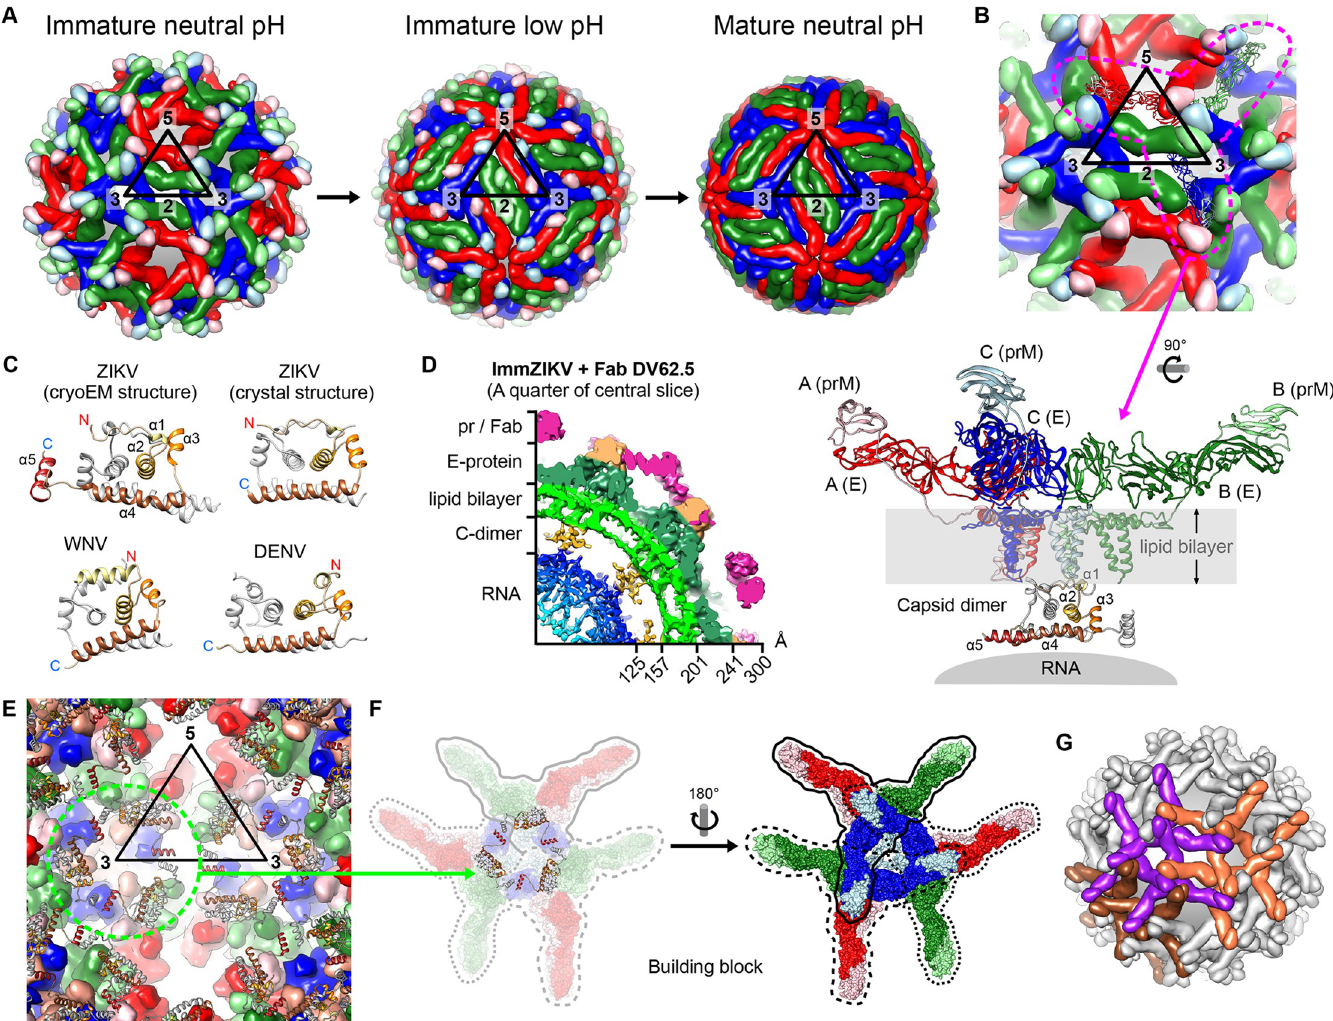
Fig 2. The organization of structural proteins in flavivirus. (A) E protein or prM–E protein arrangement on immature (left), low pH immature (center), and mature flavivirus (right) during the maturation process. An icosahedaral asu is shown as a black triangle with 5-, 3-, and 2-fold vertices indicated. The 3 individual E proteins in an asu are each located near 5-, 2-, or 3-fold vertices and are colored in red, green, and blue, respectively. (B) Three prM–E heterodimers form an inverted tripod. One of the inverted tripods is indicated with a dashed magenta line. The inverted tripods crisscross with other neighboring inverted tripods, forming the spiky immature virus surface. Underneath an inverted tripod and interacting with the TM regions of 3 E–prM is a C protein dimer. One of the C protein protomers within a dimer is colored with a gradient of brown shades, starting with lighter shades at the N-terminal end. The other protomer is colored in gray. The helices α 1– α 5 on the colored C protomer is indicated. (C) Comparison of the structures of flavivirus C proteins [8–11]. The N-terminus (red N) and C-terminus (blue C) of the C proteins are shown. (D) A quarter of the central slice of Fab DV62.5 complexed immature ZIKV cryoEM map. (E) Inside-out view of the ImmZIKV structure showing the C protein dimer organization in the immature particle around the 3-fold vertex (green dashed circle). One C dimer formed a triangular network with the other 2 C dimers through the interactions between the α 5 helices. (F) The basic building block for the virus shell consists of a triangular network of 3 C dimers interacting with 9 E–prM heterdimers. (G) One building block interacts with another through the tips of their E–prM heterodimers on the outside of the particle, thus forming a lattice. Three neighboring building blocks are shown and colored in orange, purple, and brown. asu, asymmetric unit; C, Capsid; cryoEM, cryo-electron microscopy; E, Envelope; Fab, antigen- binding fragment; ImmZIKV, immature ZIKV; prM, precursor Membrane; ZIKV, Zika virus. https://doi.org/10.1371/journal.ppat.1008542.g002 there are 2 proline residues, thus breaking the helix. The resulting long pre- α 1 loop extends the dimerization surface and enhances interactions between the 2 m-C protomers [11]. The orientation of helix α 1 with respect to helix α 2 can affect the accessibility of the hydrophobic residues on helix α 2. Interestingly, the helix α 1 of neuropathic flaviviruses such as ZIKV and West Nile virus (WNV) is positioned perpendicular to helix α 2 in a “close conformation” [12].